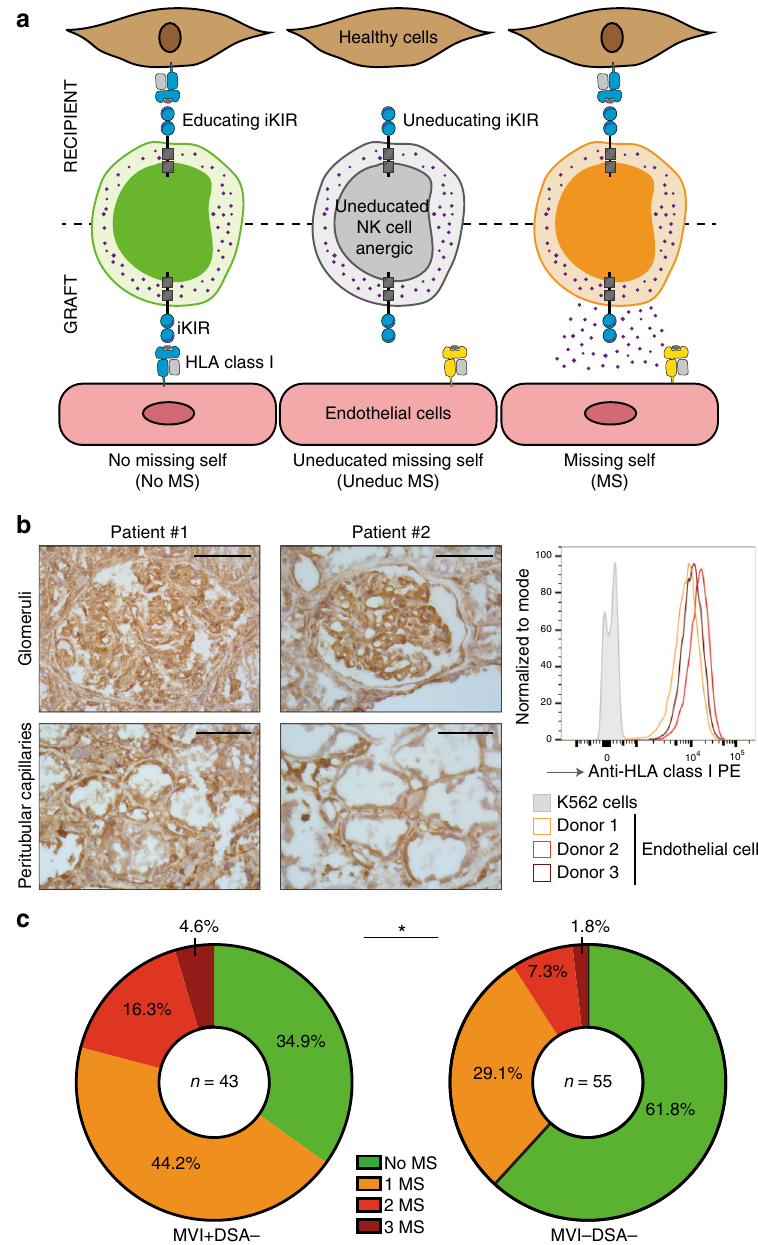
Fig. 2 Genetically predicted missing self correlates with MVI. a Schematic representation of the education process of NK cells (upper row) and the three distinct situations that can be encountered by circulating NK cells when contacting the vasculature of an allogeneic organ (lower row): absence of missing self (no MS) (left panel), presence of a missing self for a ligand not expressed by the NK cell donor (uneducated missing self, uneduc MS) (centre panel), or missing self (MS) (right panel). b Left panel: representative images showing the expression of HLA I molecules on glomeruli (upper row) and peritubular capillaries (middle row) of renal graft biopsies of two distinct patients. Scale bar: 100 µ m. Right panel: the expression of HLA I molecules was quanti fi ed on the surface of primary human endothelial cells from three different donors. K562 cells, which lack the expression of HLA molecules, were used as a negative control (grey). Representative fl ow cytometry pro fi les are shown. c Genetic analyses were conducted for each donor/recipient pair from the MVI + DSA − group (left panel) and MVI − DSA − (right panel, control), to identify situations of missing self (MS), in which allogeneic graft endothelial cells are unable to deliver the inhibitory signal to an educating inhibitory KIR of the donor. * p < 0.05; Fisher ’ s exact